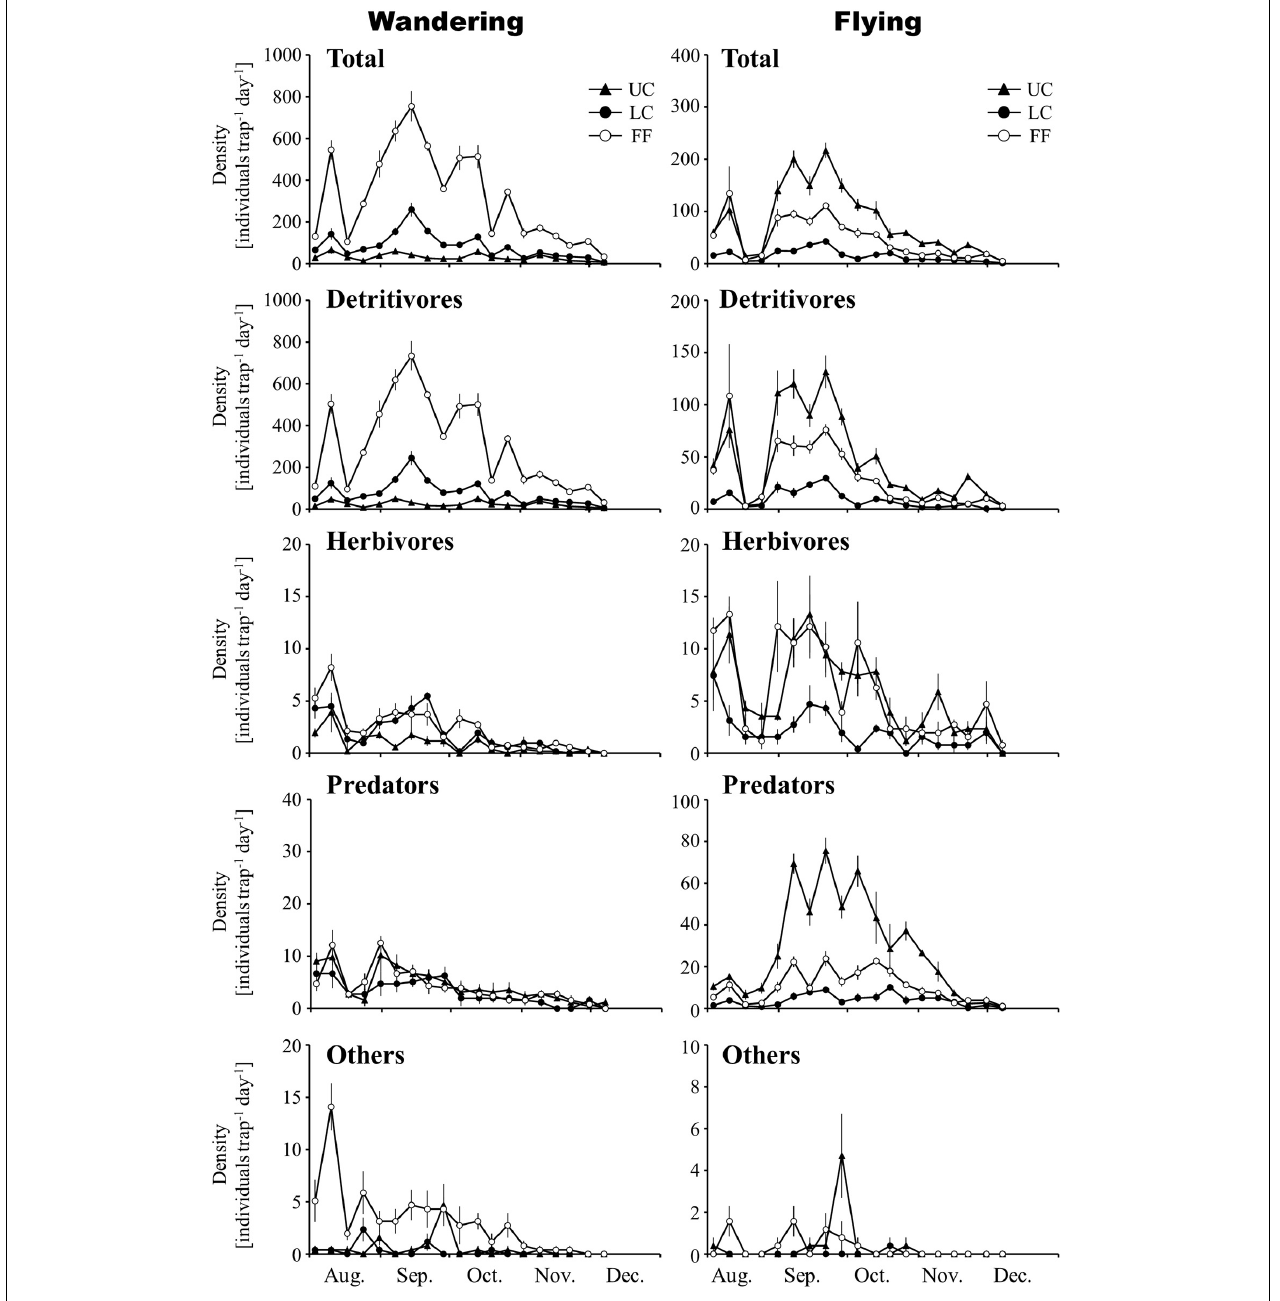
FIGURE 2 | Temporal changes in the density of arthropod groups collected by water-pan traps in the vertical strata of a Japanese cedar ( Cryptomeria japonica ) forest. Values represent mean ± standard error. UC, upper canopy; LC, lower canopy; FF, forest floor.